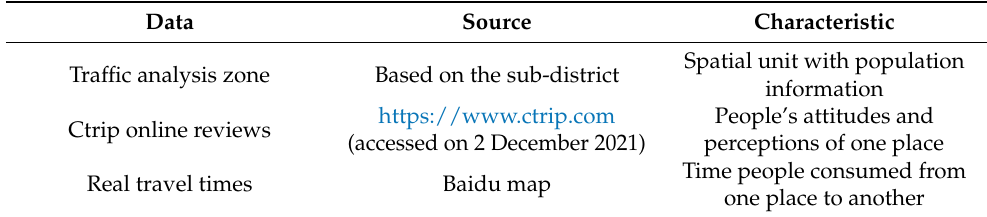
Table 1. The information of datasets.